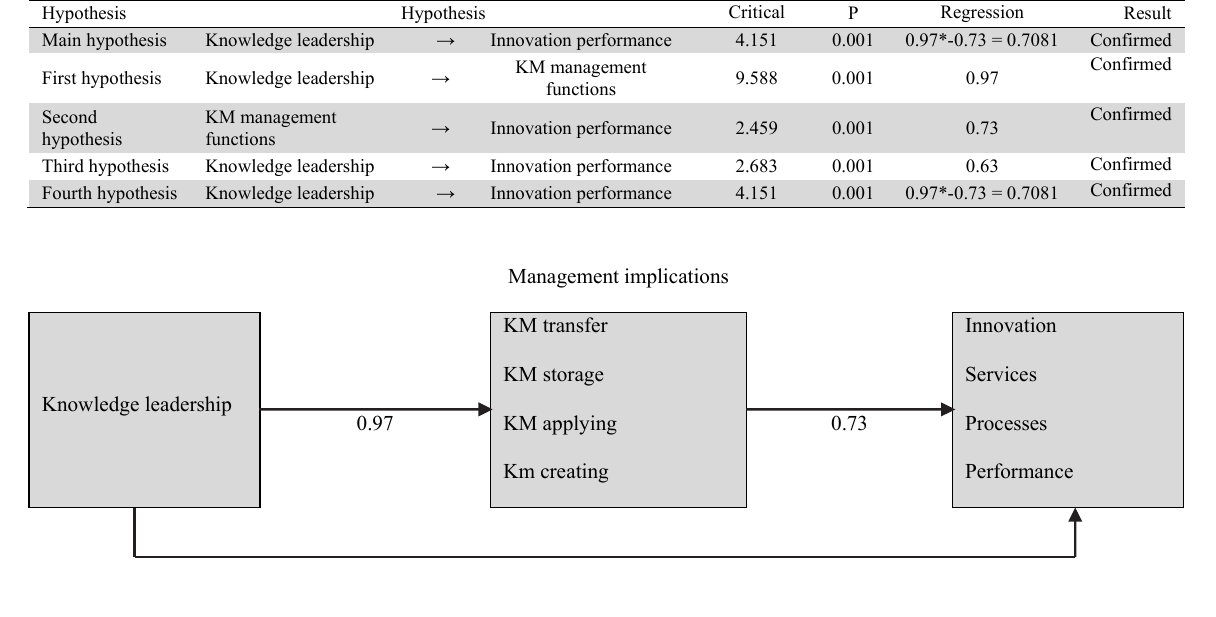
Fig. 3. The results of the proposed study of this